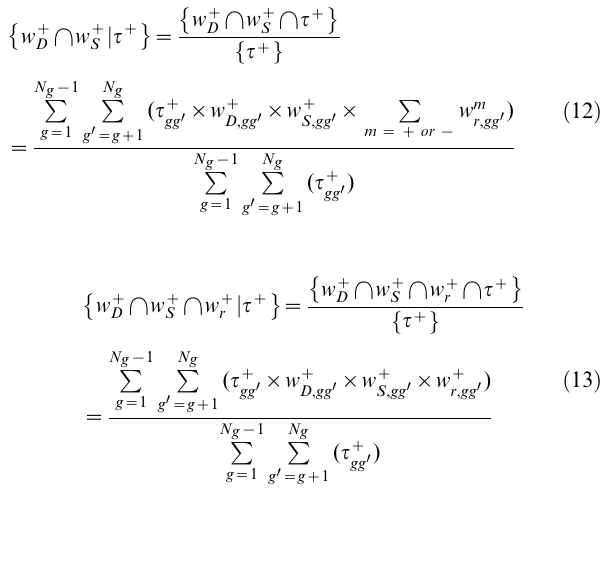
Figure S1 Expression ranking preservation of HK genes in cattle tissues. The thresholds (C t ) for the cycle numbers of real-time PCR experiments for six HK genes in cattle tissues showed rank preservation. In general, C t is negatively correlated with gene expression level. Data from Lisowski et al. [22]. (PDF) Figure S2 HK genes selected from different pathways span a wider range of expression levels. The expression ranges of HK genes in each of the 7 HK-enriched pathways for two tissues are shown by mean value (small solid circles) and standard errors (error bars) of their expression levels in log2 scale. The Kendall’s tau, (cid:2) tt gg 0 for HK genes selected from different pathways was computed to be 0.75 6 0.00 for 100 runs of random sampling of 7 HK genes, each from one of the 7 HK-enriched pathways.